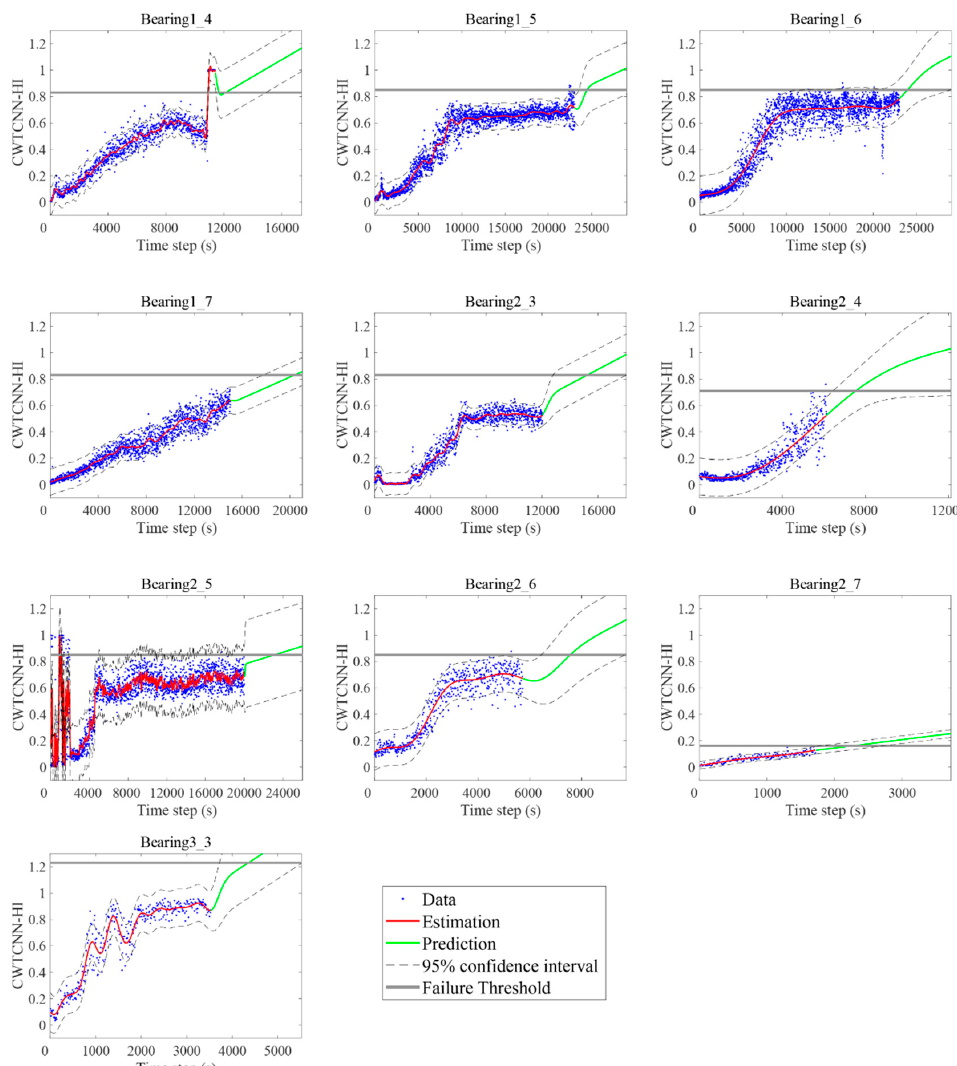
Figure 10. RUL prediction results of the other ten testing datasets.